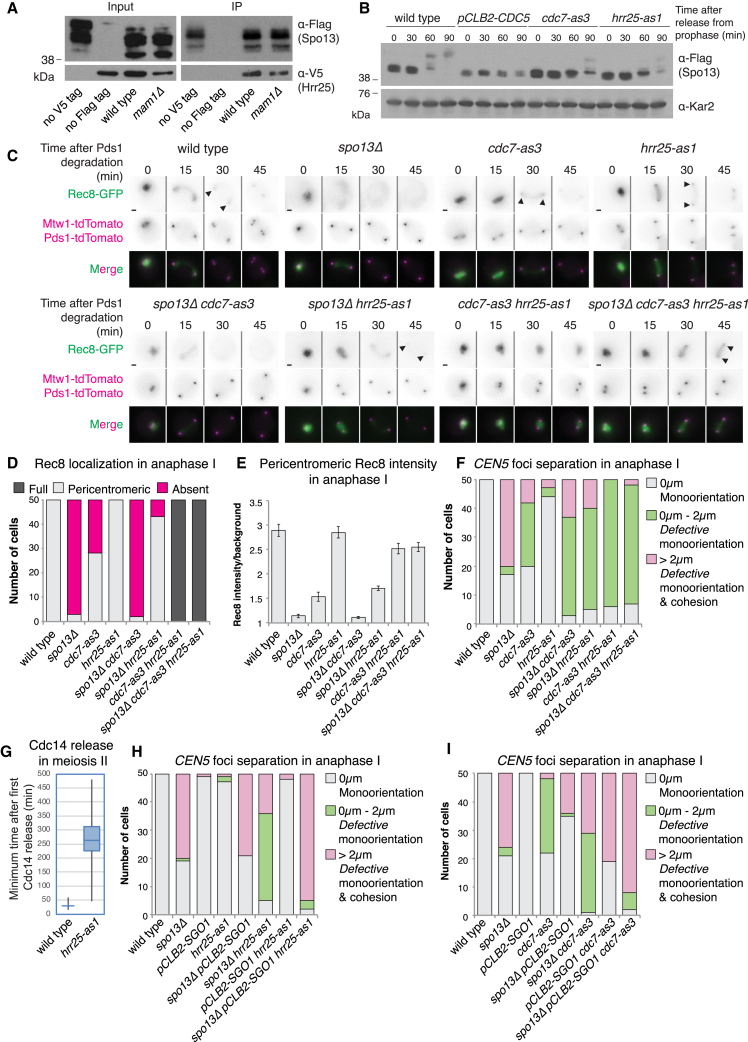
Inhibition of Cohesin Kinases Prevents Cohesion Loss in spo13Δ Mutants in an Sgo1-Dependent Manner(A) Immunoblot shows Hrr25-V5 co-immunoprecipitates with Spo13-3Flag.(B) Immunoblot analysis of Spo13-3Flag and Kar2 loading control after release from prophase into a metaphase I arrest.(C–E) Inhibition of Hrr25 and Cdc7 in spo13Δ cells. (C) Representative time-lapse images. Scale bars, 1 μm. Arrows indicate pericentromeric cohesin. (D) Scoring of Rec8-GFP localization. (E) Intensity of pericentromeric Rec8-GFP with standard error bars.(F) Heterozygous CEN5-GFP distance categorization upon Hrr25 and Cdc7 inhibition as in Figure 2E.(G) Confirmation of hrr25-as1 inhibition. Time between rounds of Cdc14 release measured from the experiment in Figure 6H. Boxes represent first and third quartile, whiskers indicate minimum and maximum values and the horizontal line shows the median.(H and I) Sister chromatid cohesion upon Hrr25 (H) and Cdc7 (I) inhibition requires Sgo1. Heterozygous CEN5-GFP distances scored as in Figure 2E.See also Figure S5.